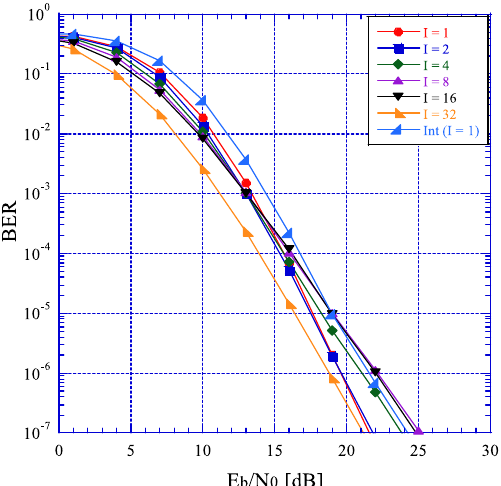
Fig. 13 BER of the various E b / N 0 for the power combination with the DFT, the MMSE, and the